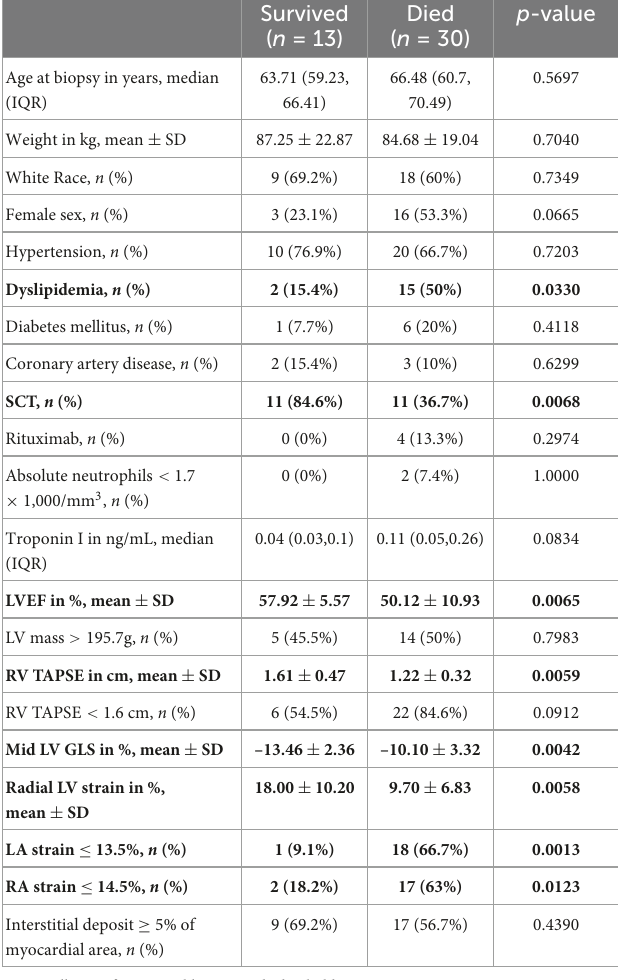
TABLE 3 Immunohistochemical classification of cardiac amyloid extent and pattern.